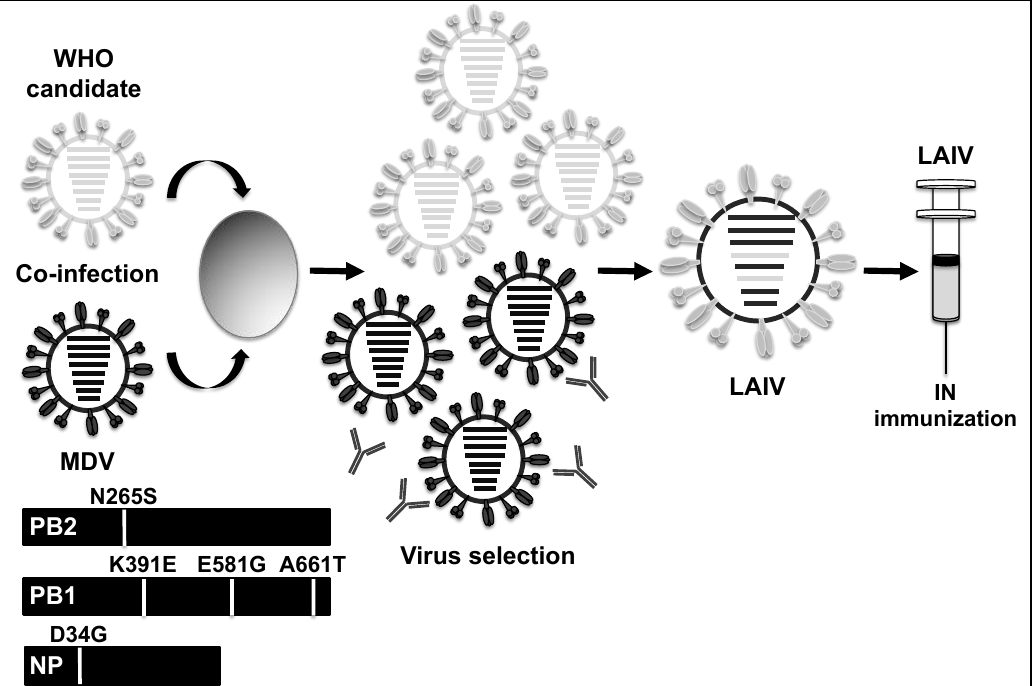
Figure 3. Generation of the live-attenuated influenza vaccine (LAIV): The LAIV is produced by co-infection of 10–11 days old chicken embryonated eggs with the candidate virus recommended by the WHO (top, gray) and the A/Ann Arbor/6/60 H2N2 (bottom, black) Master Donor Virus (MDV). After 2–3 days post-infection, the appropriate reassortant seed virus containing the six internal segments (PB2, PB1, PA, NP, M, and NS) derived from the MDV (black) and the two glycoprotein (HA and NA) segments from the recommended WHO circulating strain (gray) is selected by amplification at low temperatures in the presence of antibodies against the MDV, HA, and NA. The selected LAIV is then administrated intranasally (IN). Amino acid substitutions in the PB2 (N265S), PB1 (K391E, E581G, and A661T) and NP (D34G) viral segments responsible for the attenuated (att), temperature sensitive (ts), and cold-adapted (ca) phenotype of the MDV A/Ann Arbor/6/60 H2N2 are indicated at the